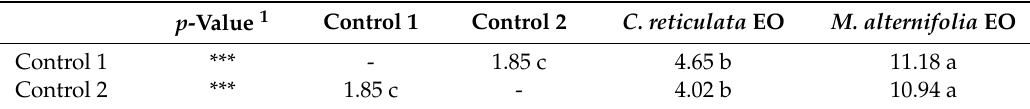
) according to ab